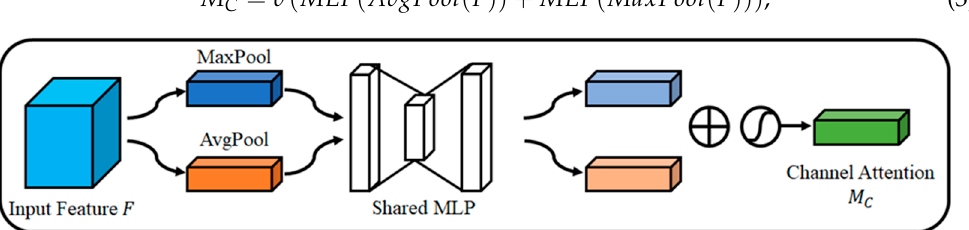
Figure 4. Channel Attention Module.